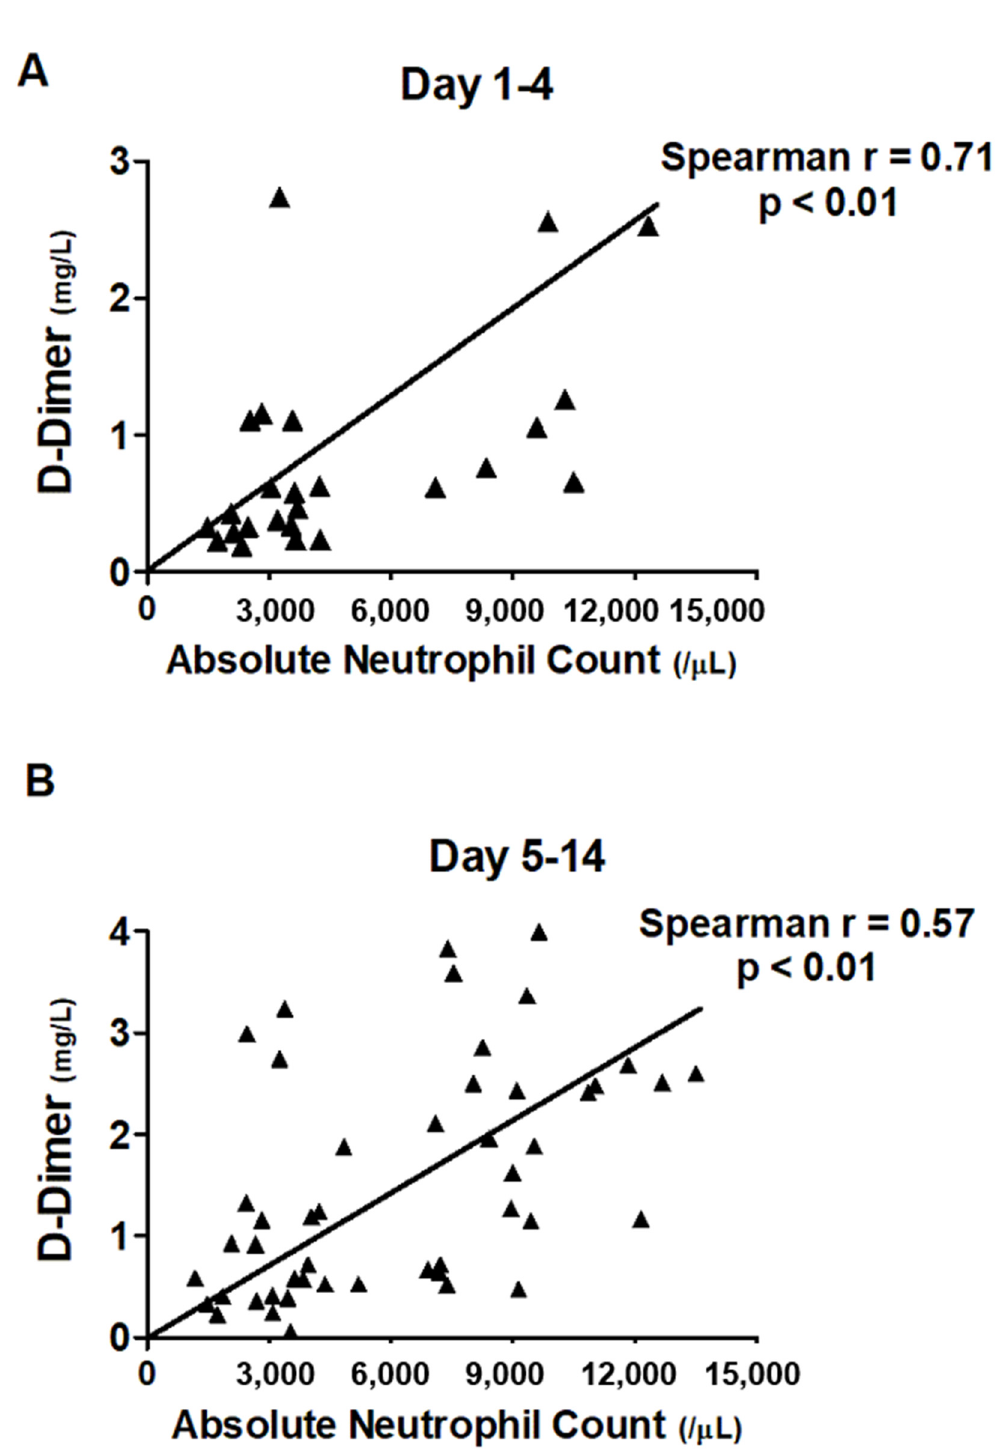
Figure 2. Correlation between the level of D-Dimer and neutrophil count among patients with COVID categorized by hospital day: ( A ) day 1–4, ( B ) day 5–14.